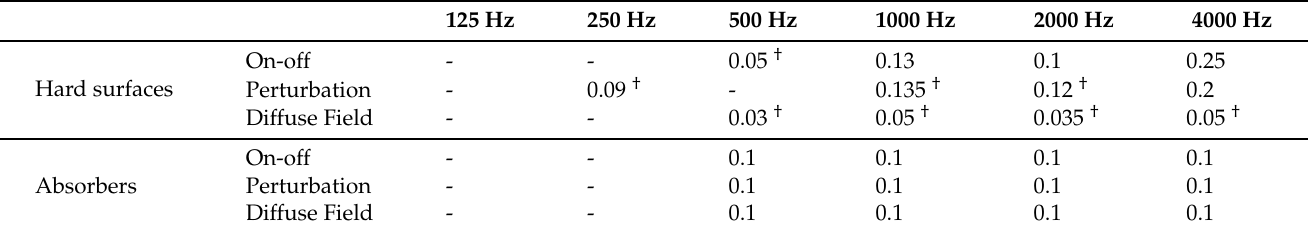
Table 3. Suitable scattering values for the two cases and different algorithms. They have been determined using the method described in Figure 4. Missing values indicate that no scattering value could be found for which the average room acoustic parameters were accurate. Values indicated by † are scattering values that outperform other scattering values in the given case, although some room acoustic parameters are outside 1